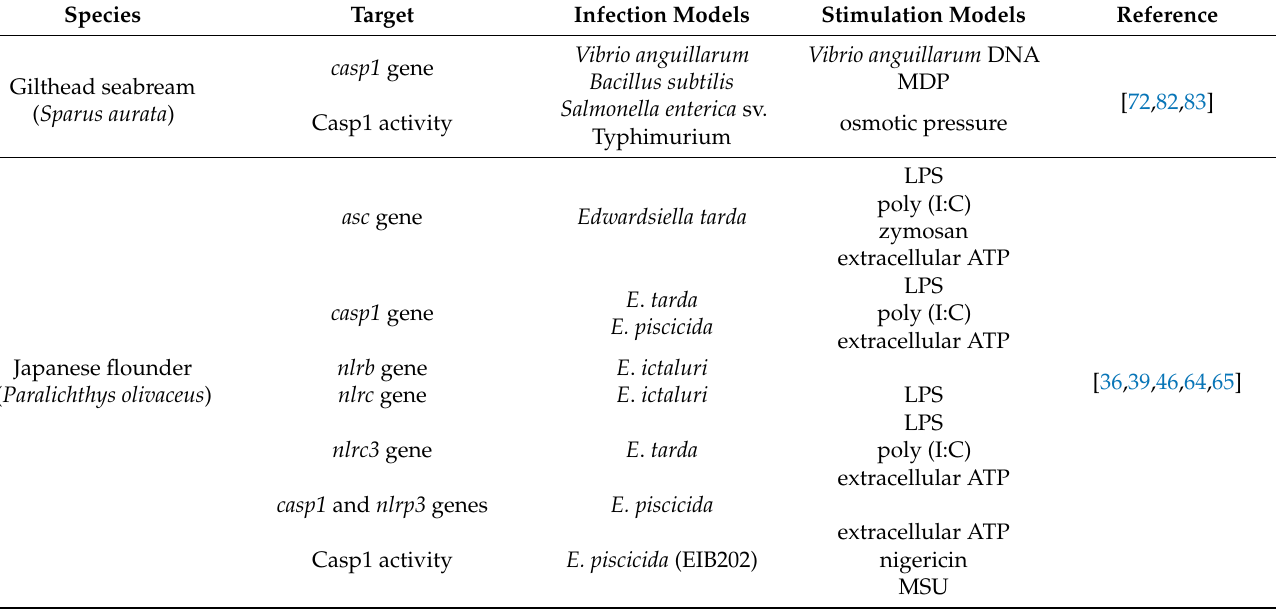
Table 2. Inflammasome priming and activation by pathogenic infection or stimulation in fish.